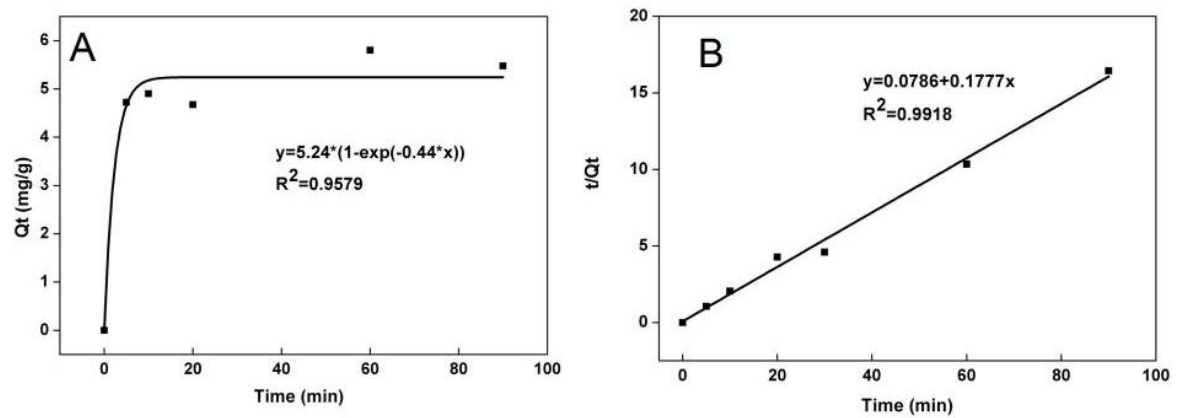
Figure 6. Fitting results of first-order kinetic and second-order kinetic. ( A ) for first-order kinetic and ( B ) for second-order kinetic.